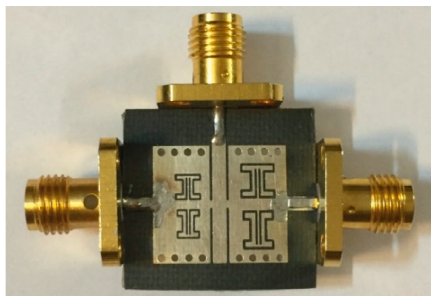
Figure 19: Image of the fabricated diplexer